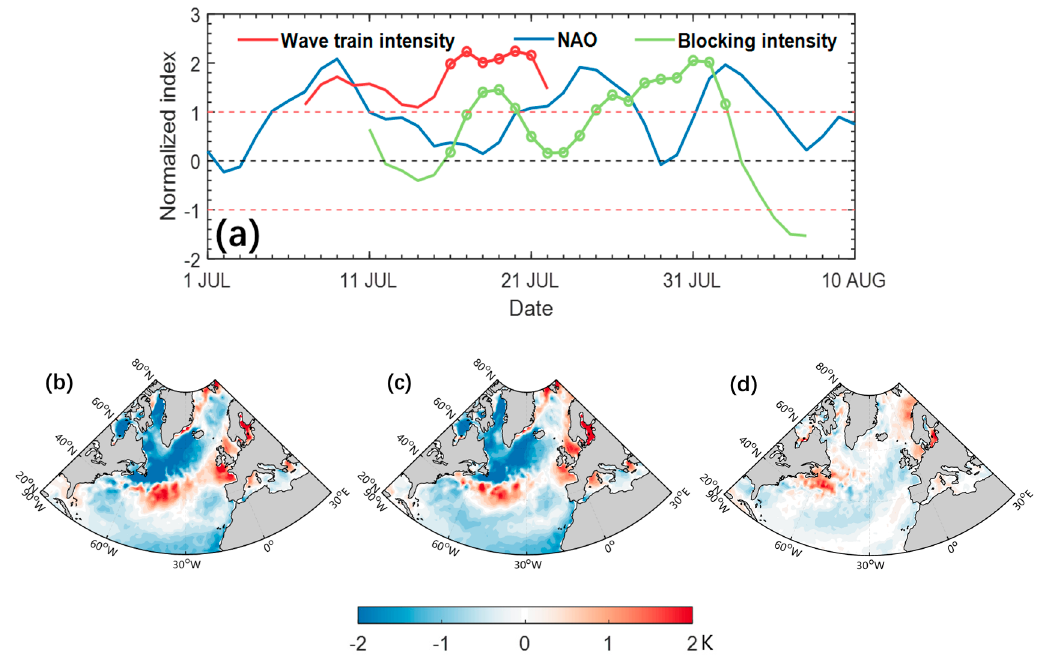
Figure 11. ( a ) Daily variations in the normalized NAO index (blue line), blocking intensity index (green line) and midlatitude wave train intensity index (red line). The red circles denote the days of the midlatitude wave train and the green circles represent the blocked days. The 1 ( − 1) standard deviation is denoted by the red dashed line. Sea surface temperature (SST) anomalies for the ( b ) midlatitude wave train period (16–21 July) ( c ) high latitude wave train period (22–28 July) and ( d ) the difference between ( b ) and ( c ) over the northern Atlantic sector.